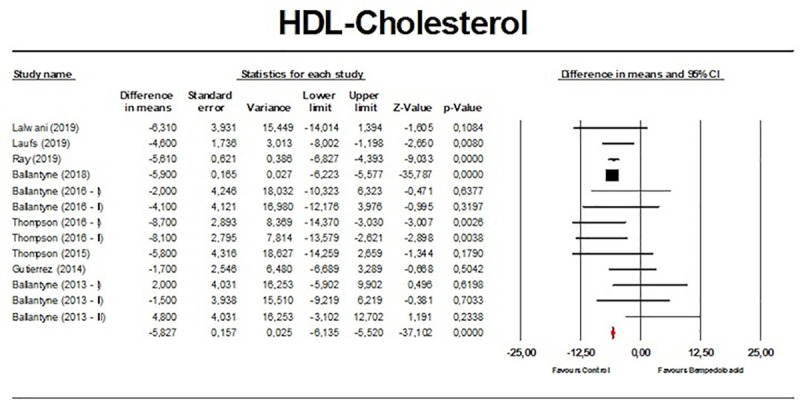
Forest plot displaying mean difference and 95% confidence intervals for the effect of bempedoic acid on plasma levels of high-density lipoprotein (HDL) cholesterol.